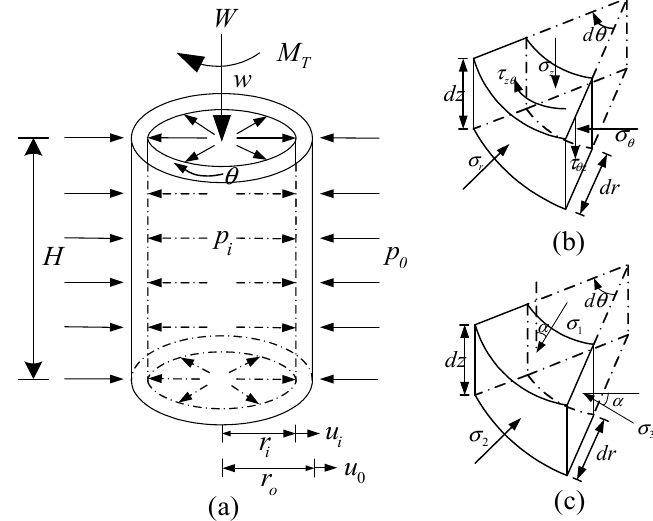
Figure 2. GDS hollow cylinder apparatus test system .